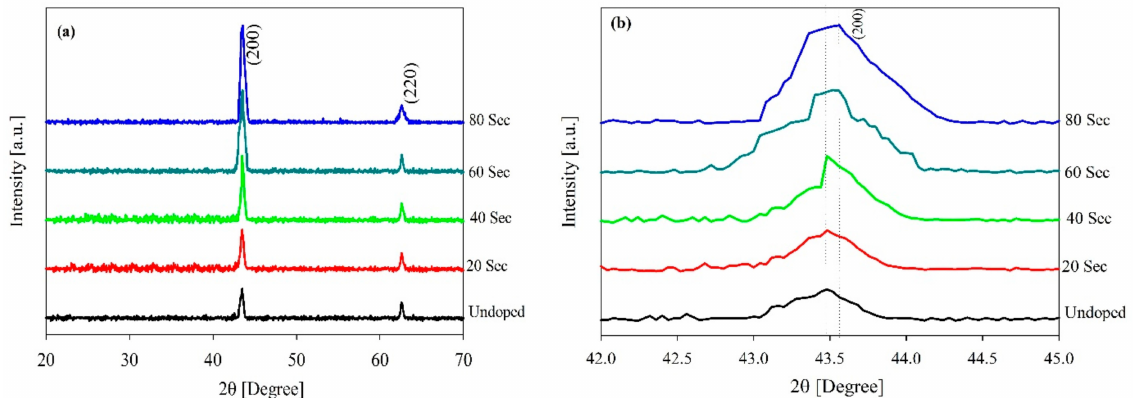
Figure 2. Structural properties of the NiO thin films at different doping times; ( a ) XRD pattern; ( b ) comparative studies on the (200) plane peak obtained from XRD